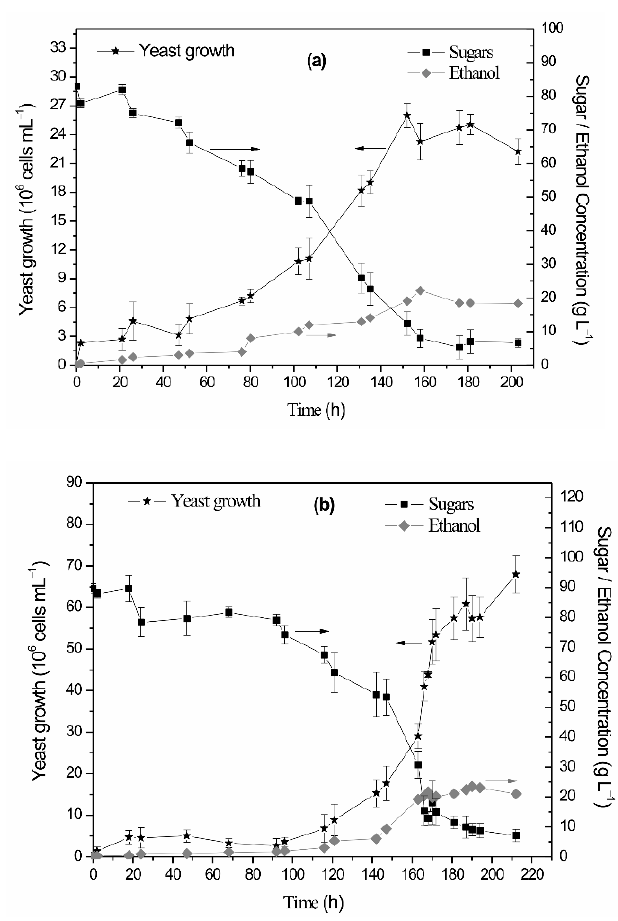
Figure 1. Profiles of yeast growth, sugar depletion and ethanol production through time using synthetic medium cyanobacterial biomass substrates treated with H 2 SO 4 at: ( a ) 60 min and ( b ) 120 min.